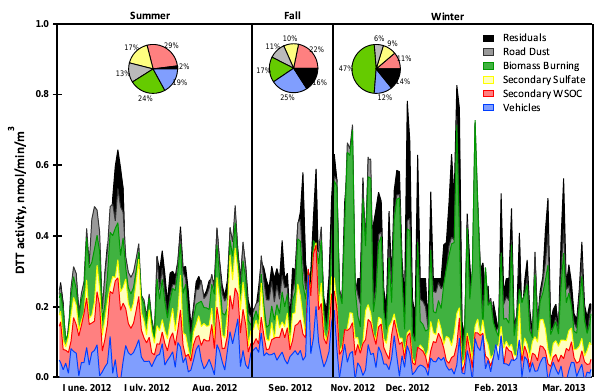
Figure 7. Time series of PM 2 . 5 DTT activity segregated into differ- ent factors as predicted by PMF and their seasonal